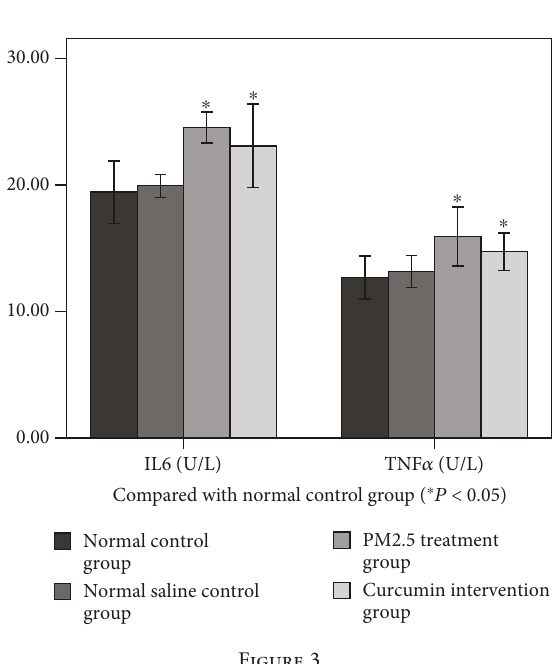
PM2.5 treatment